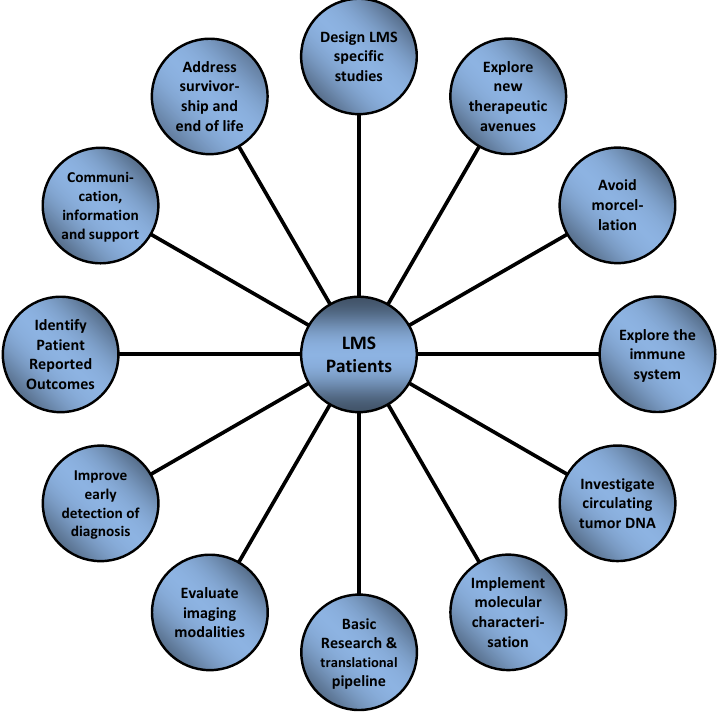
Figure 2. Future perspectives for the management of patients diagnosed with